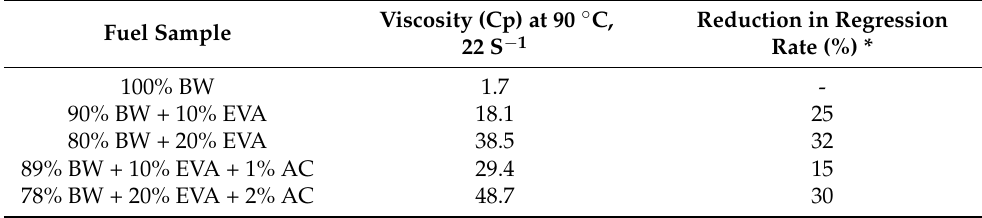
Table 4. Viscosity of BW–EVA-based solid fuels. Fuel